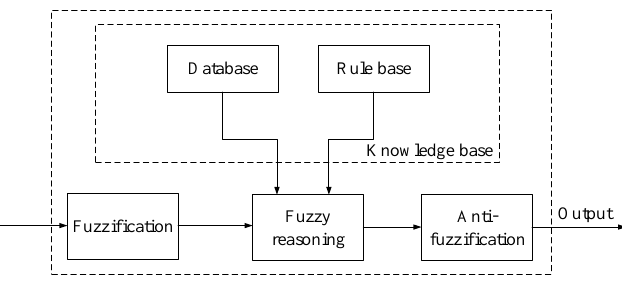
Figure 5. Fuzzy control architecture.